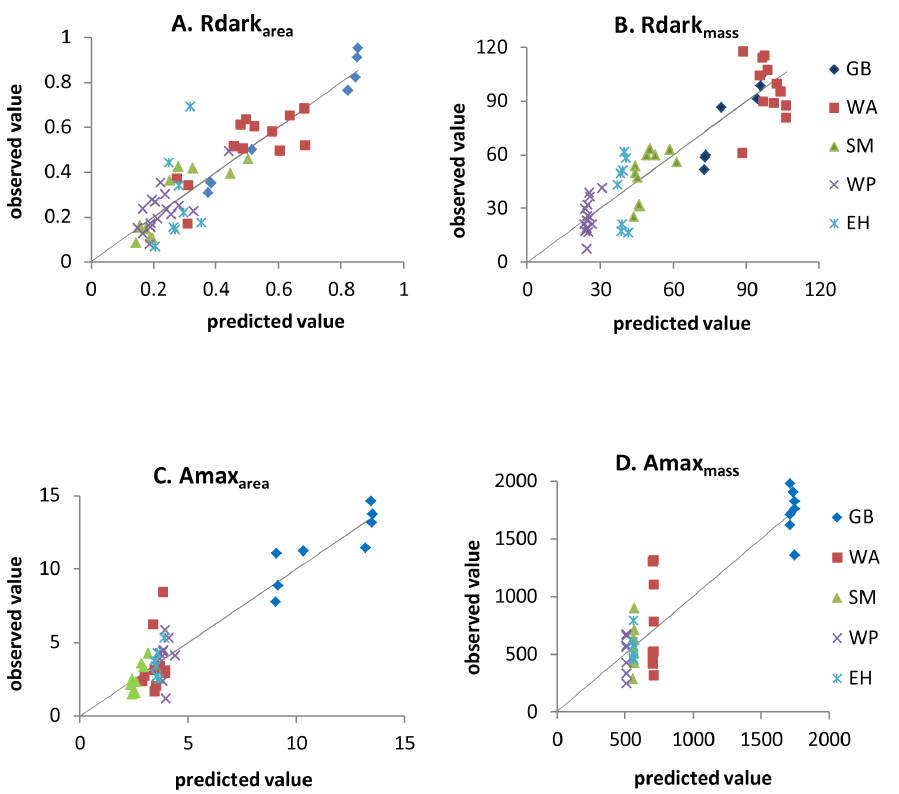
Figure 1. Measured vs. predicted values from Model 3a (universal D and species-specific m ). Dash lines are 1:1. The model explains between-species variation in all four cases (area- and mass-based Amax and Rdark). The amount of within-species variation explained is greatest for Rdark area (Figure 1a) and least for Amax mass (Figure 1d). Units for per-area Amax and Rdark are m mol CO 2 m 2 2 s 2 1 , and units for per-mass Amax and Rdark are 10 2 4 m mol CO 2 g 2 1 s 2 1 . Species code: GB=gray birch, WA=white ash, SM=sugar maple, WP=white pine, EH=eastern